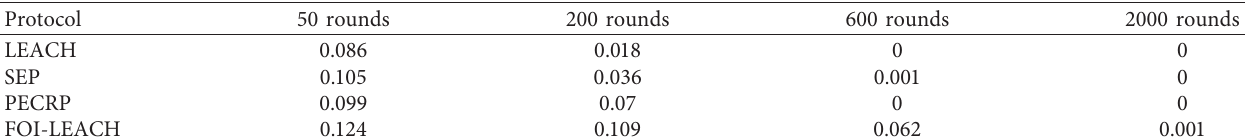
Table 5: Statistics of the average residual energy (J) of nodes of the four protocols with power supply.